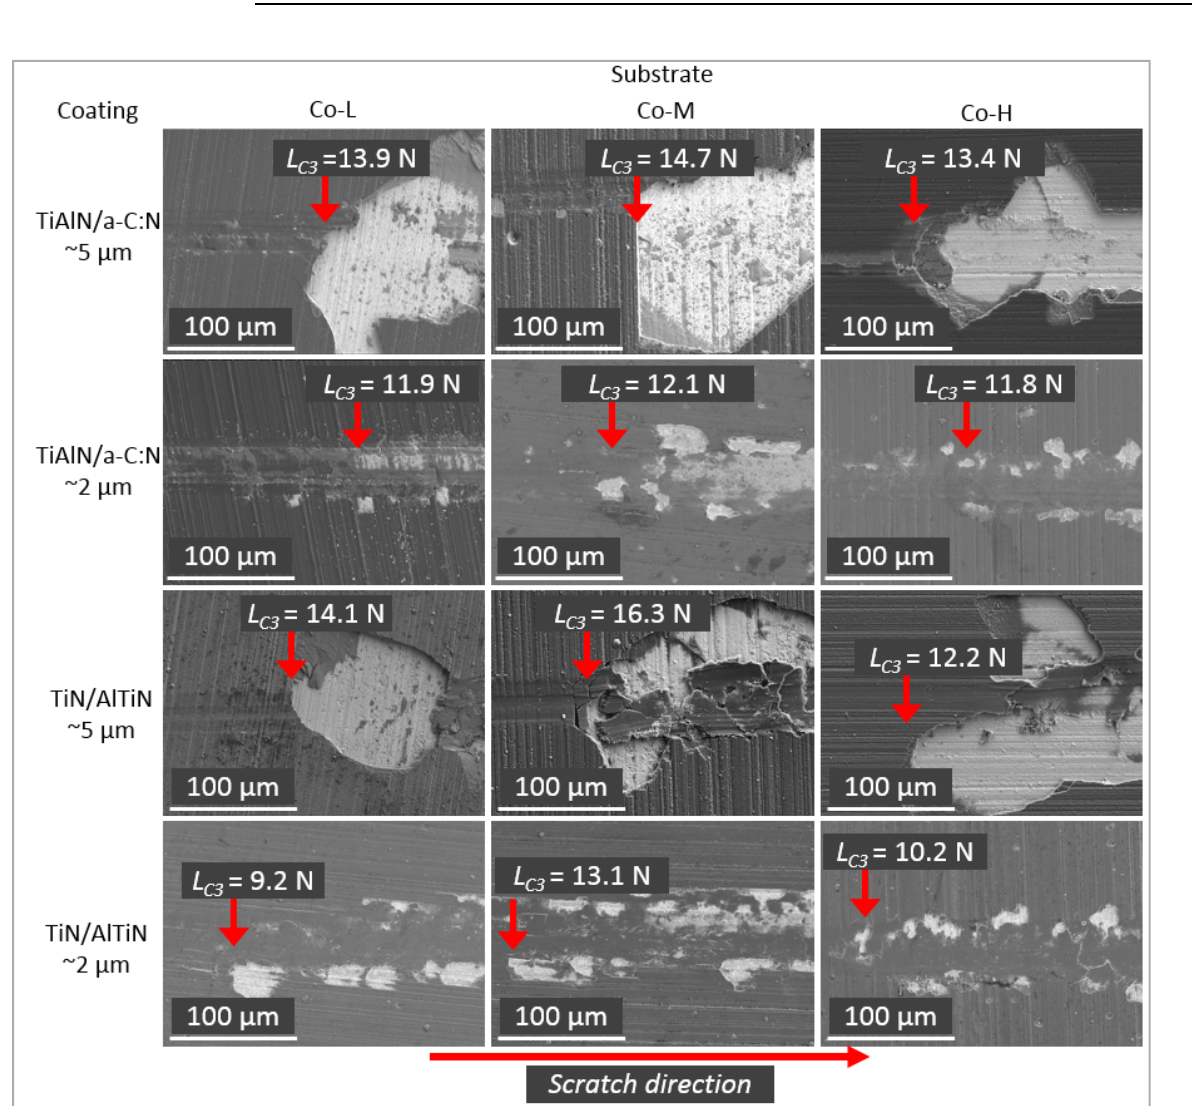
Figure 8. SEM images of the scratch tracks at the position of the critical load L C3 of the nanolayer TiN/AlTiN and TiAlN/a-C:N double layer coating deposited on Co-L, Co-M and Co-H substrates.